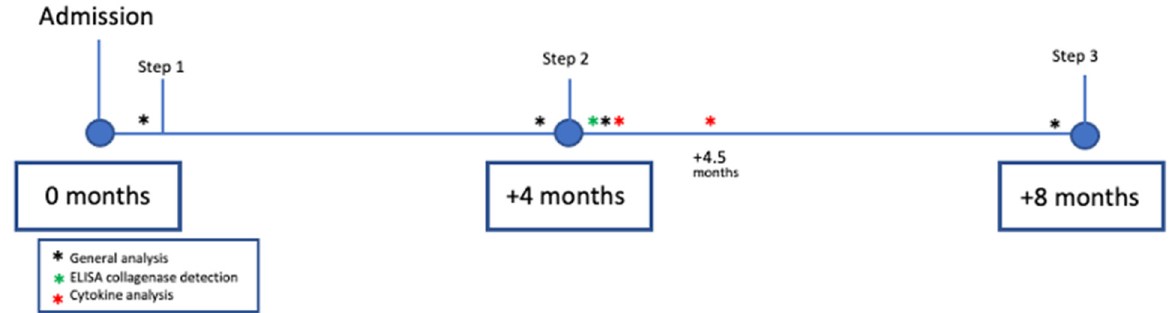
Figure 1. Flow chart: Step 1: (+1 month): Adhesion generation; Step 2: (+4 months): Adhesion analysis and treatment. Mesh removal after treatment; Step 3: (+8 months): Analysis of newly generated adhesions associated with the surgical process and necropsy of